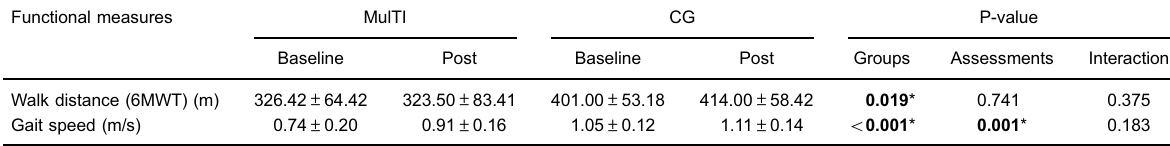
Table 5. Functional measures of the multicomponent training intervention group (MulTI) and control group (CG). Functional